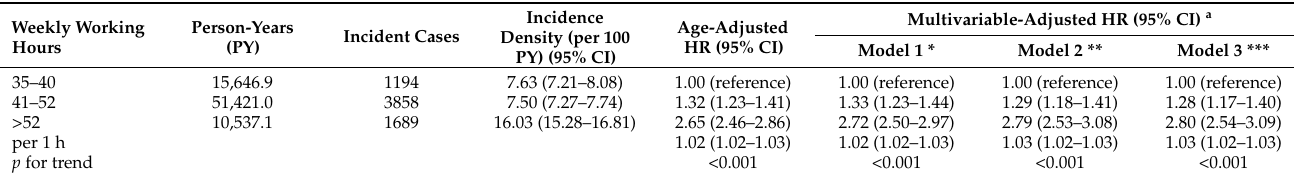
Table 2. Incidence and risk of glucose intolerance according to weekly working hours.